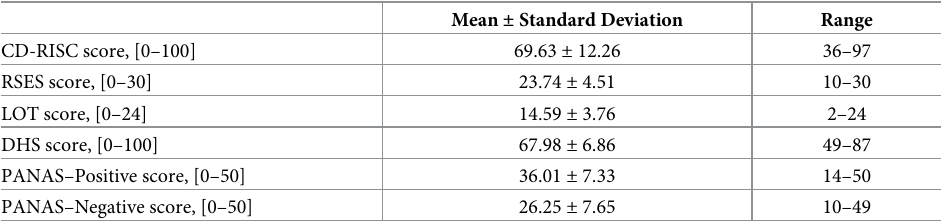
Table 1. Descriptive analyses of the studied scales among a sample of Lebanese